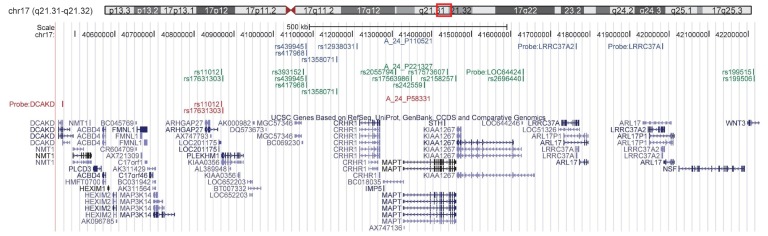

MAPT region probes and SNPs involved in significant cis eSNP relationships.Three probes in the MAPT region on chromosme 17 showing significant association with PD risk SNPs are displayed. Significant SNP associations with A_24_P110521 located in the duplicated genes LRRC37A and LRRC37A2 are shown in blue, while SNPs associated with A_24_P221327 located in LOC644246 are shown in green and SNPs associated with A_24_P58331 (in DCAKD) are shown in red.